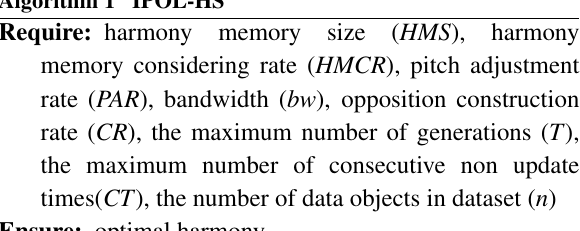
Algorithm 1 IPOL-HS